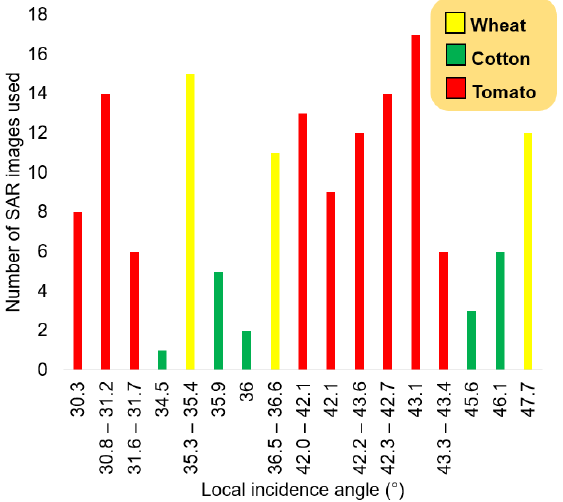
Figure 3. The number of SAR images acquired at different local incidence angles used in the modeling of different crops.